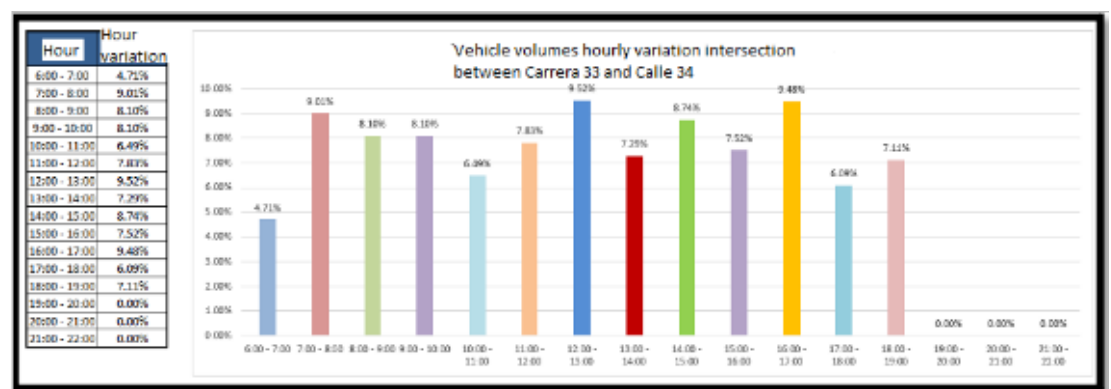
Figure 7: Hourly variation of volume vehicles at intersection 1 (carrera 33 with street 34).